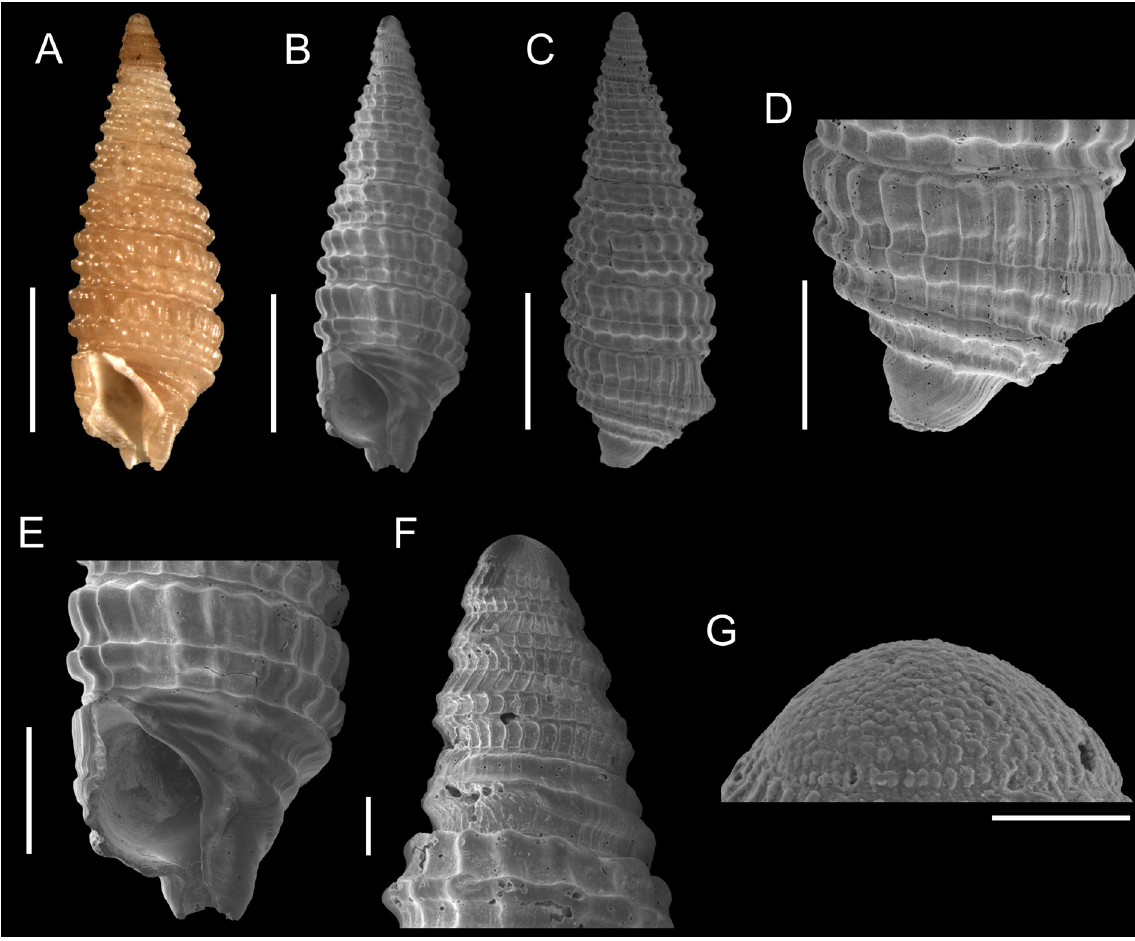
Fig. 16. Sagenotriphora sp. 2. A–G . IBUFRJ 19556, 3.09 mm. Scale bars: A–C = 1 mm; D–E = 500 µm; F = 100 µm; G = 50